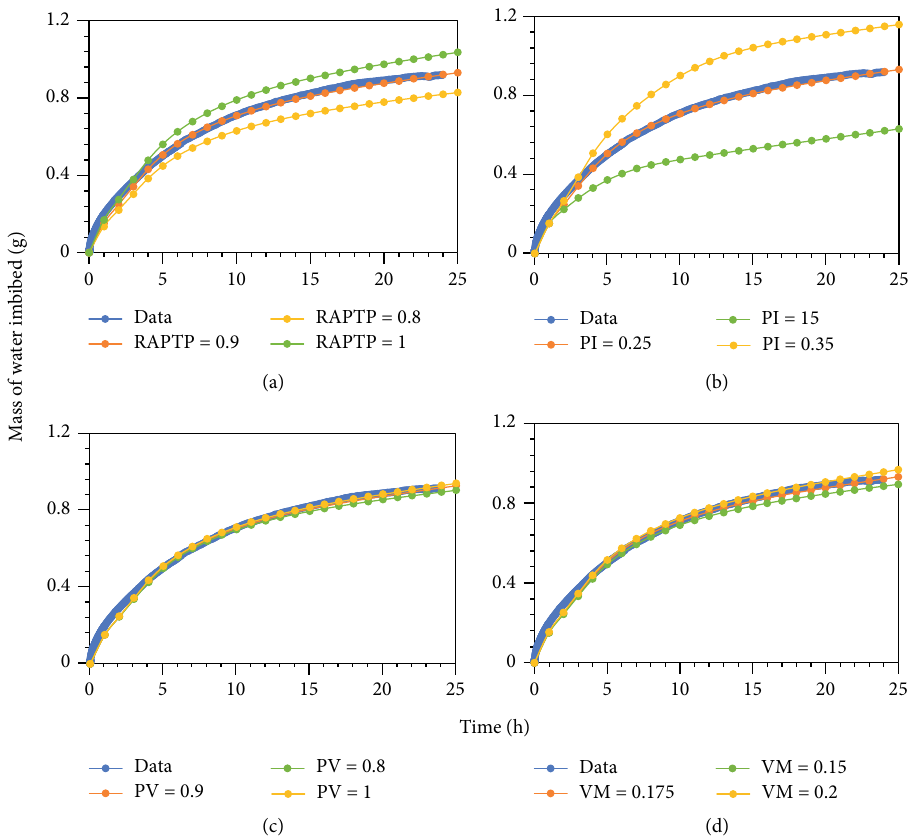
Figure 11: Comparison of the imbibed water mass and simulation of the Barnett Shale sample with P direction, as in fl uenced by (a) RAPTP, (b) probability of imbibition (PI) in matrix cells,(c) probability of vapor (PV) absorption in matrix cells, and (d) maximum of vapor (MV) saturation in matrix cells.